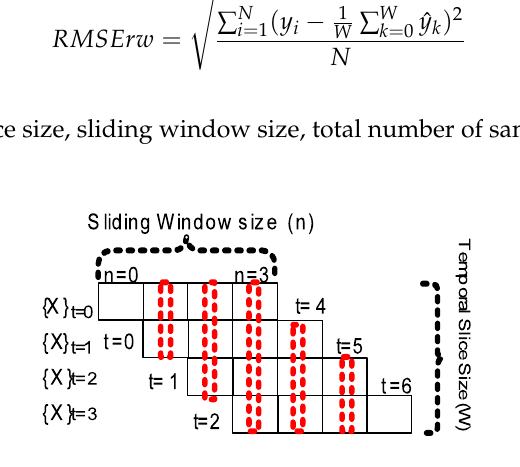
Figure 16. Rolling Window Forecast for n-ahead (e.g., n = 3) Forecast for each input sequence { X } t . Sub-samples from previous W predicted sequences at each temporal (red vertical stripes) slice in sliding windows can be combined appropriately (e.g., averaged, max or min polled, etc.) together for calculating rolling window forecast